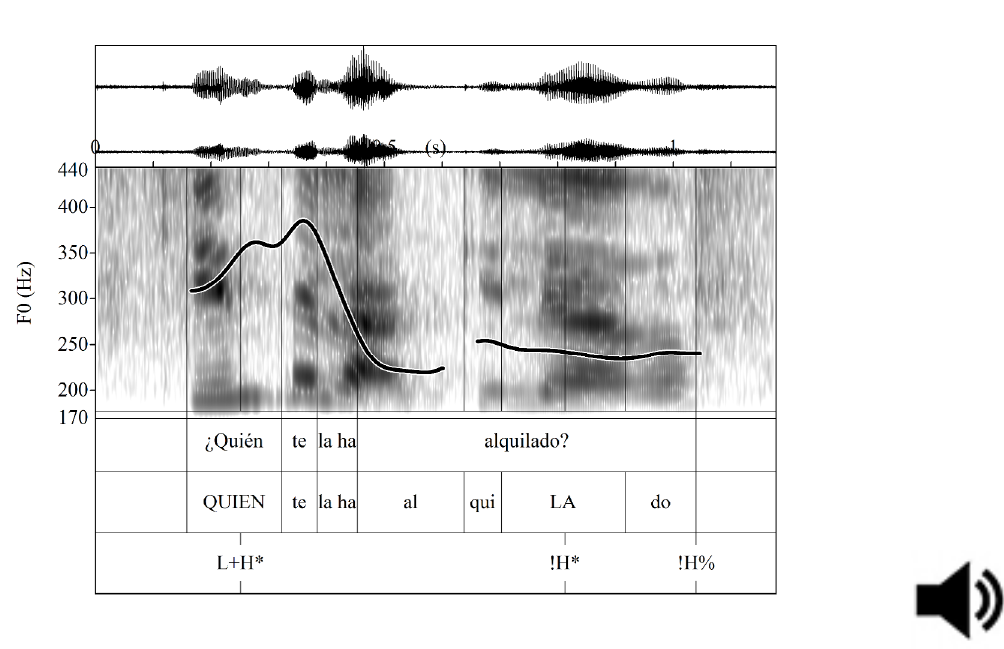
Figure 22 (Participant 11): Waveform and F0 trace for the neutral wh- question ¿Quién te la ha alquilado? ‘Who has rented you the house?’ produced as L+H* (in prenuclear position) and as !H* !H% (nuclear